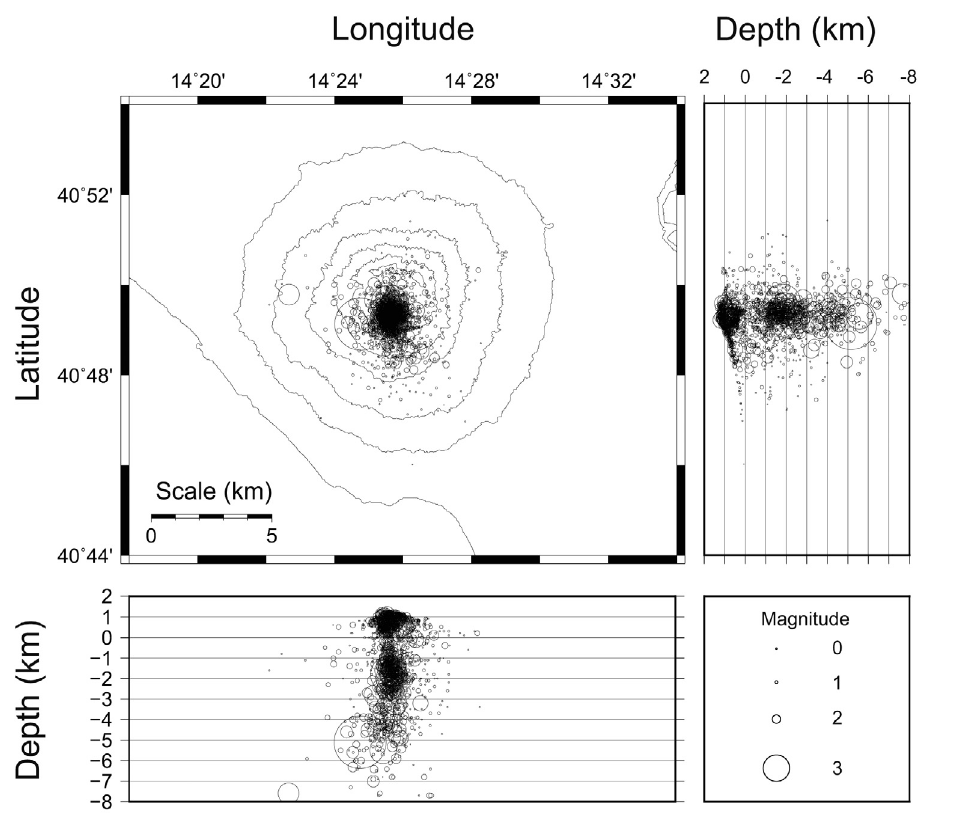
Figure 6. Earthquake hypocenters for the 1999-2012 interval. The top left panel shows earthquake epicenters for events whose location un- certainty (ERH and ERZ) is less than 1 km. The size of simbols is proportional to the event magnitude (see the legend on the lower right). The plot on the left shows hypocenters projected on a NS cross-section, while the lower plot shows an EW cross-section. The second has a peak between 0.5 and 1 km a.s.l. The isolated spike indicated by the arrows is relative